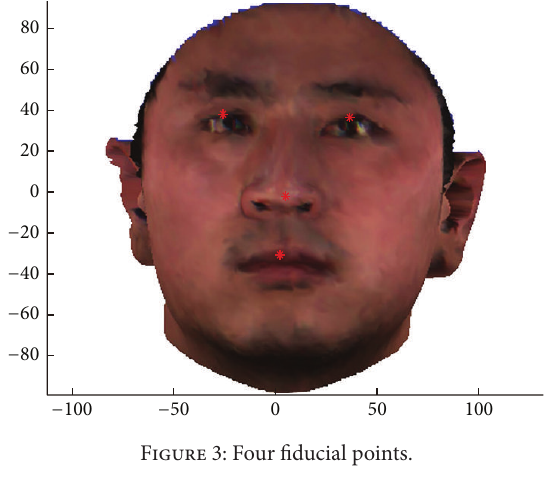
Figure 3: Four fiducial